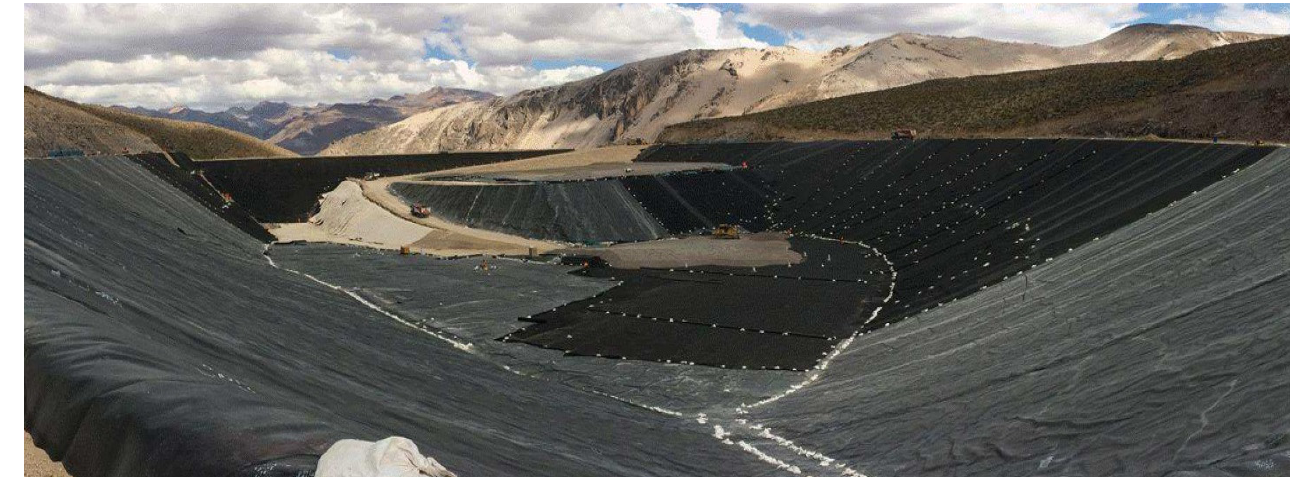
Figure 73. Tambomayo Filtered TSF [42,43,71,72].